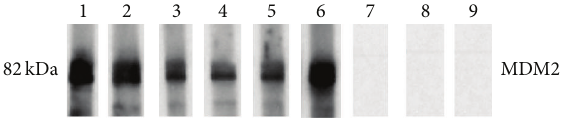
Figure 2: Western blotting analysis with representative sera in ELISA. Lanes 1–6: six representative SLE sera which were positive in ELISA and also had strong reactivity with MDM2 recombinant protein in western blotting analysis. Lanes 7–9: three randomly selected NHS had negative reactivity with MDM2 recombinant protein. Table 1: Frequency of autoantibody against MDM2 in human sera by ELISA. Number Anti-MDM2 (+) Frequency 23.30%